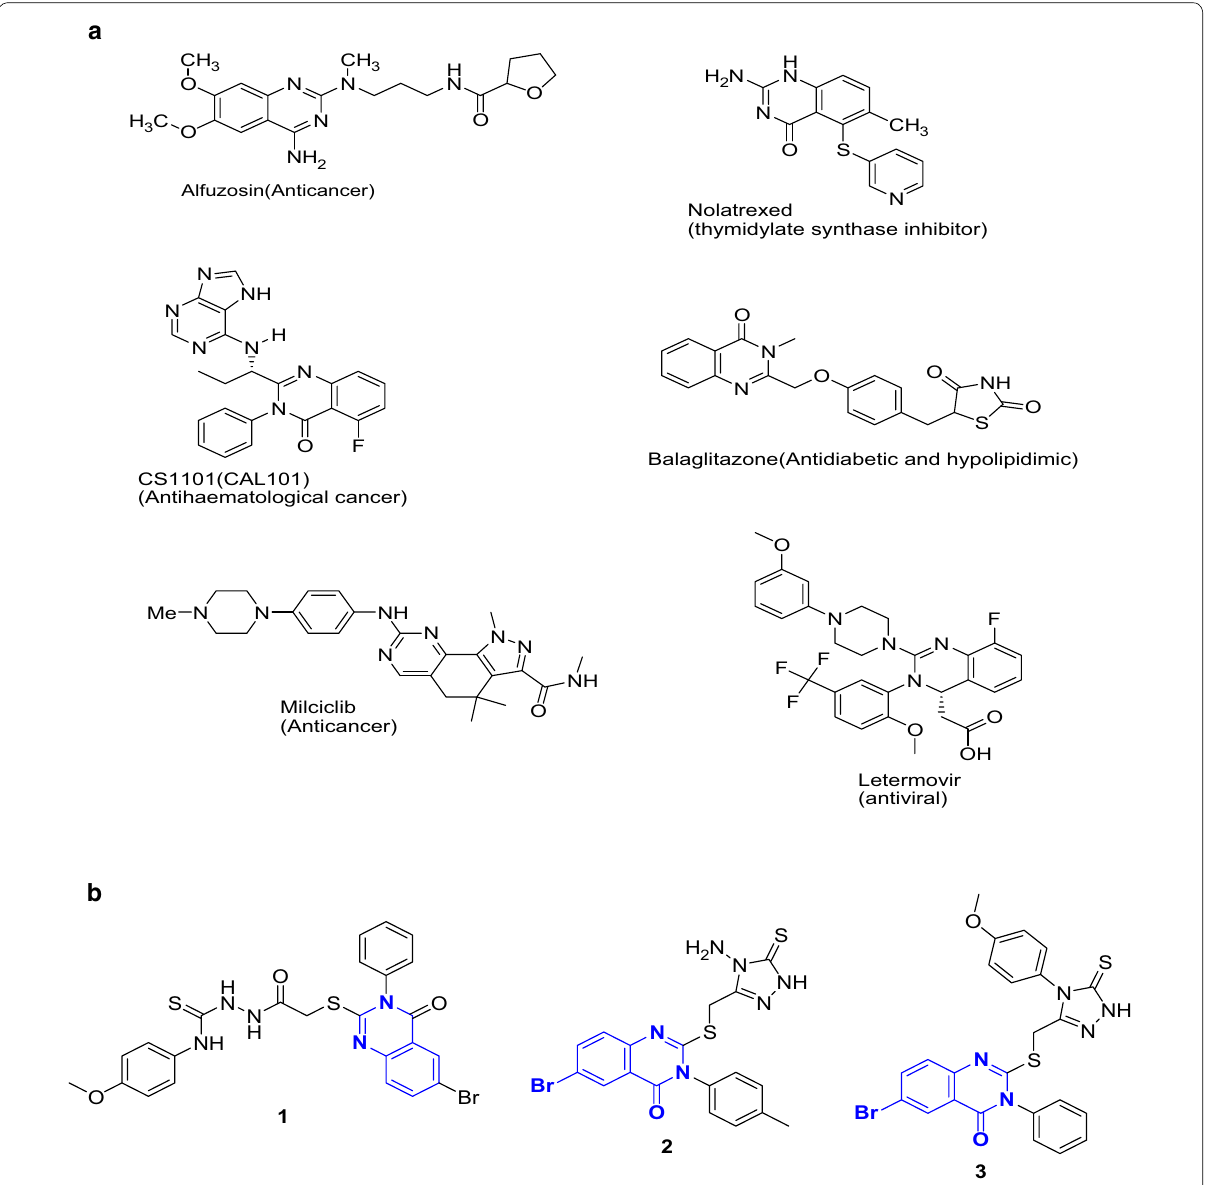
Fig. 1 a Examples of some the marketed drugs that contain quinazoline ring and their uses. b The tested quinazoline derivatives 1 –